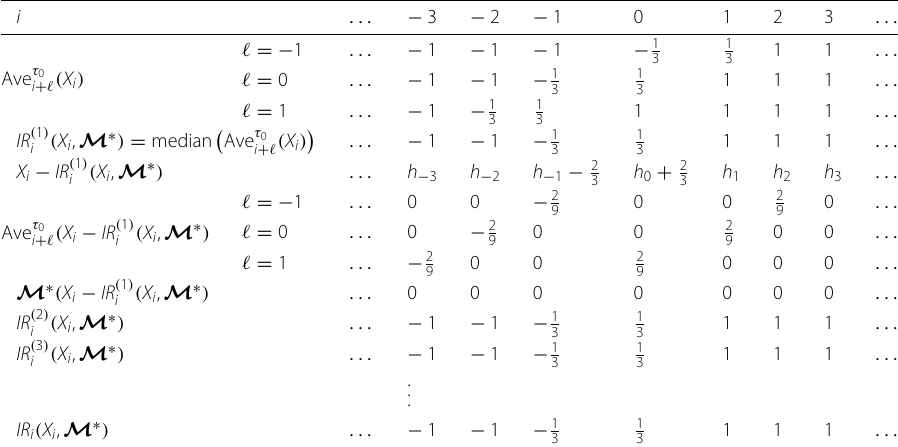
IR i ( X i , M ∗ ) ... − 1 − 1 − 1